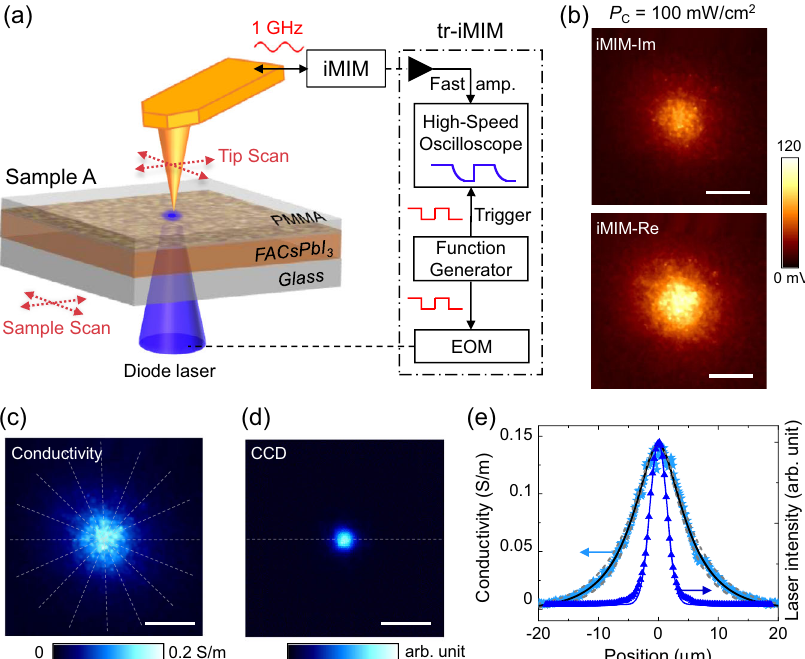
Fig. 1 Photoconductivity mapping on FACsPbI 3 and diffusion analysis. a Schematic of the iMIM setup with either the tip-scan or sample-scan mode. The tr-iMIM con fi guration is shown inside the dash-dotted box. The FACsPbI 3 thin fi lm deposited on a glass substrate and encapsulated by a PMMA layer (Sample A) is also illustrated. b Tip-scan iMIM images when the sample is illuminated by a 446-nm diode laser at P C = 100 mW/cm 2 . c Photoconductivity map based on the iMIM data and FEA simulation. The dashed lines are various linecuts for the calculation of average signals. d Image of the laser spot taken by a CCD camera. e Line pro fi les of averaged photoconductivity and laser intensity, from which the diffusion length can be extracted. The solid black and dashed gray lines represent the best curve fi tting and upper/lower bounds, respectively. All scale bars are 10 μ